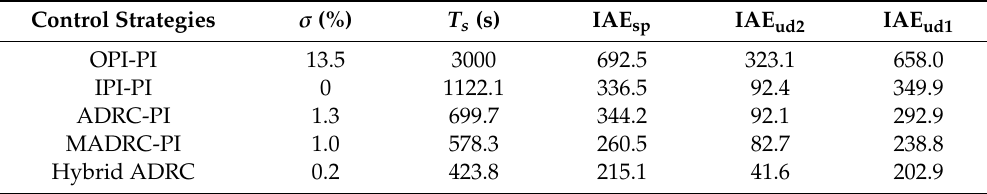
Table 2. Dynamic indices of SST with di ff erent control